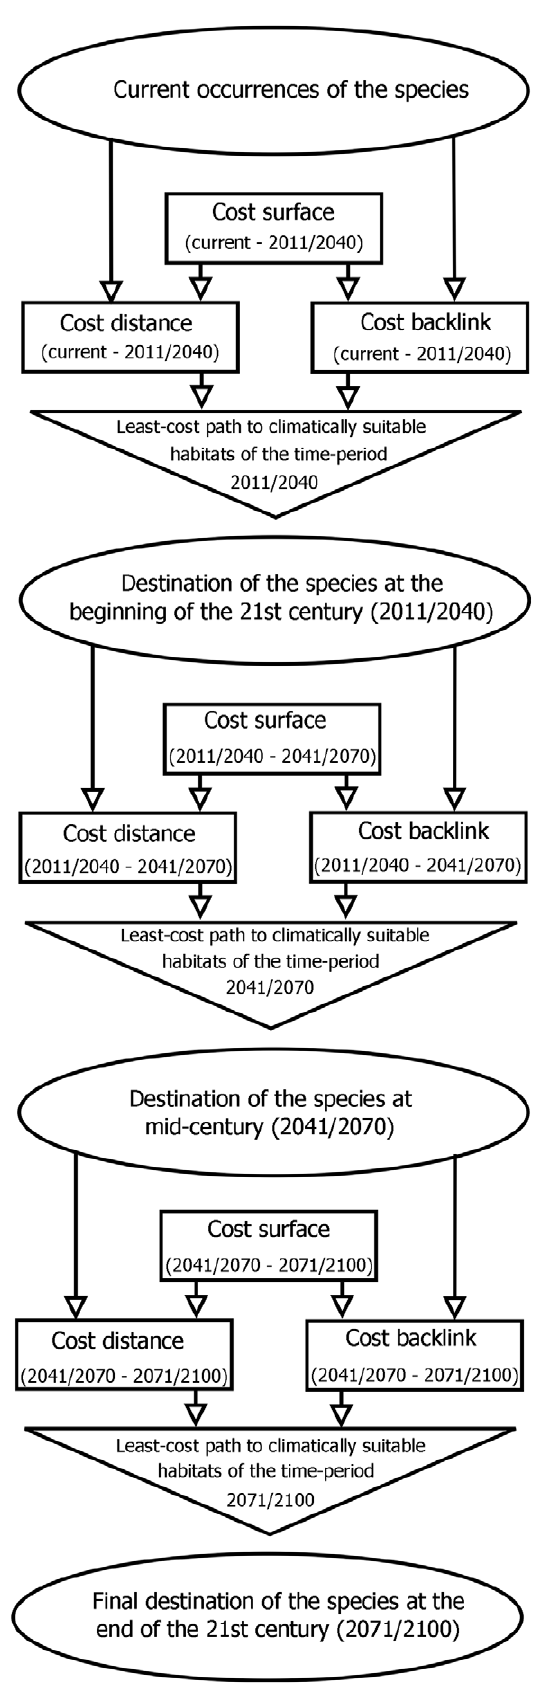
Figure 2. Principle of the least-cost analysis. Least-cost analysis was used to determine the most likely way of natural dispersal sandfly species in the 21 st